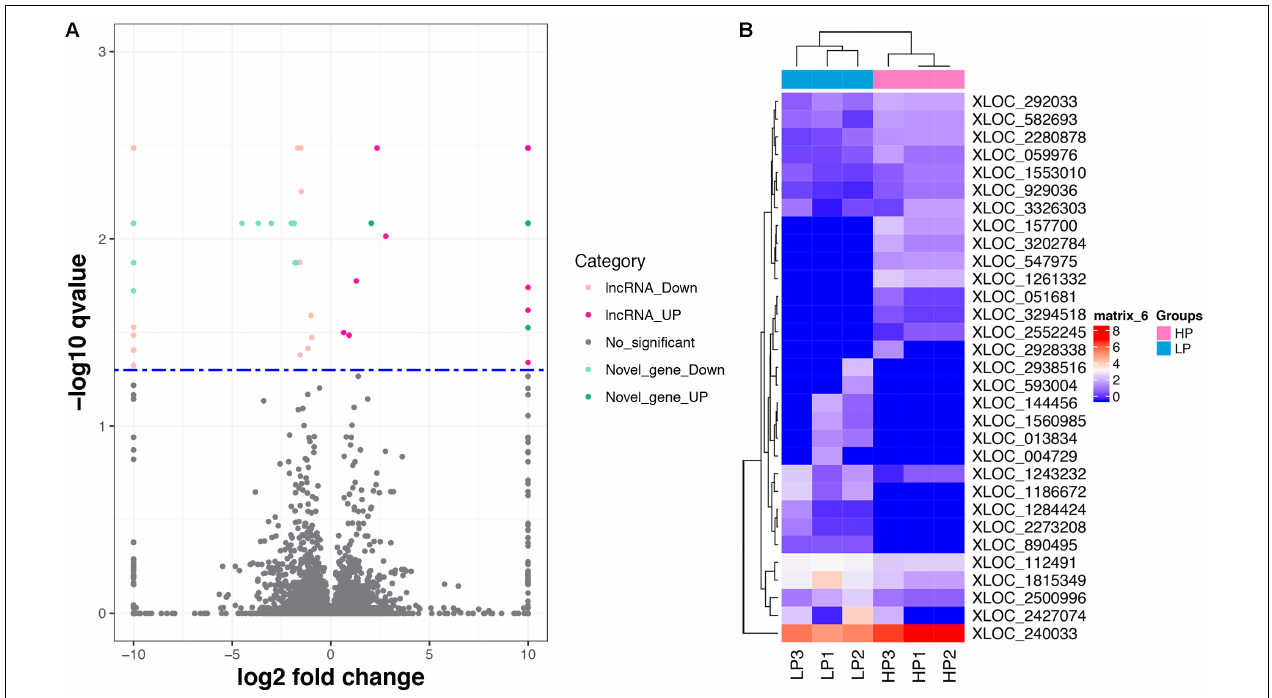
FIGURE 3 | The differentially expressed lncRNAs and mRNAs. (A) Volcano plot displaying differentially expressed lncRNAs and mRNAs within two different comparison groups. The red and orange dots represent the differentially expressed lncRNAs ( q < 0.05); the light blue and blue dots represent the differential expressed mRNAs ( q < 0.05); the gray dots represent transcripts whose expression levels did not reach statistical significance ( q > 0.05). (B) Cluster analysis of differentially expressed